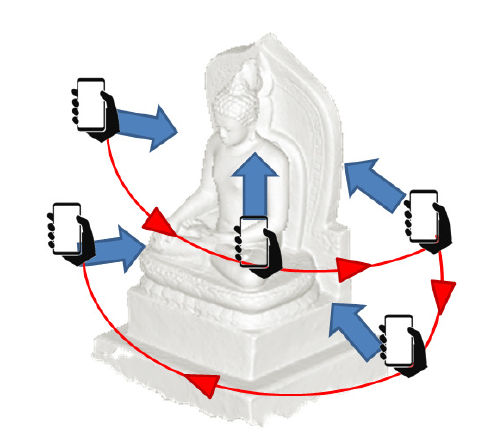
Figure 1. Illustration of the video acquisition method used in this paper. The main idea is to shoot a video converging around the object in question.